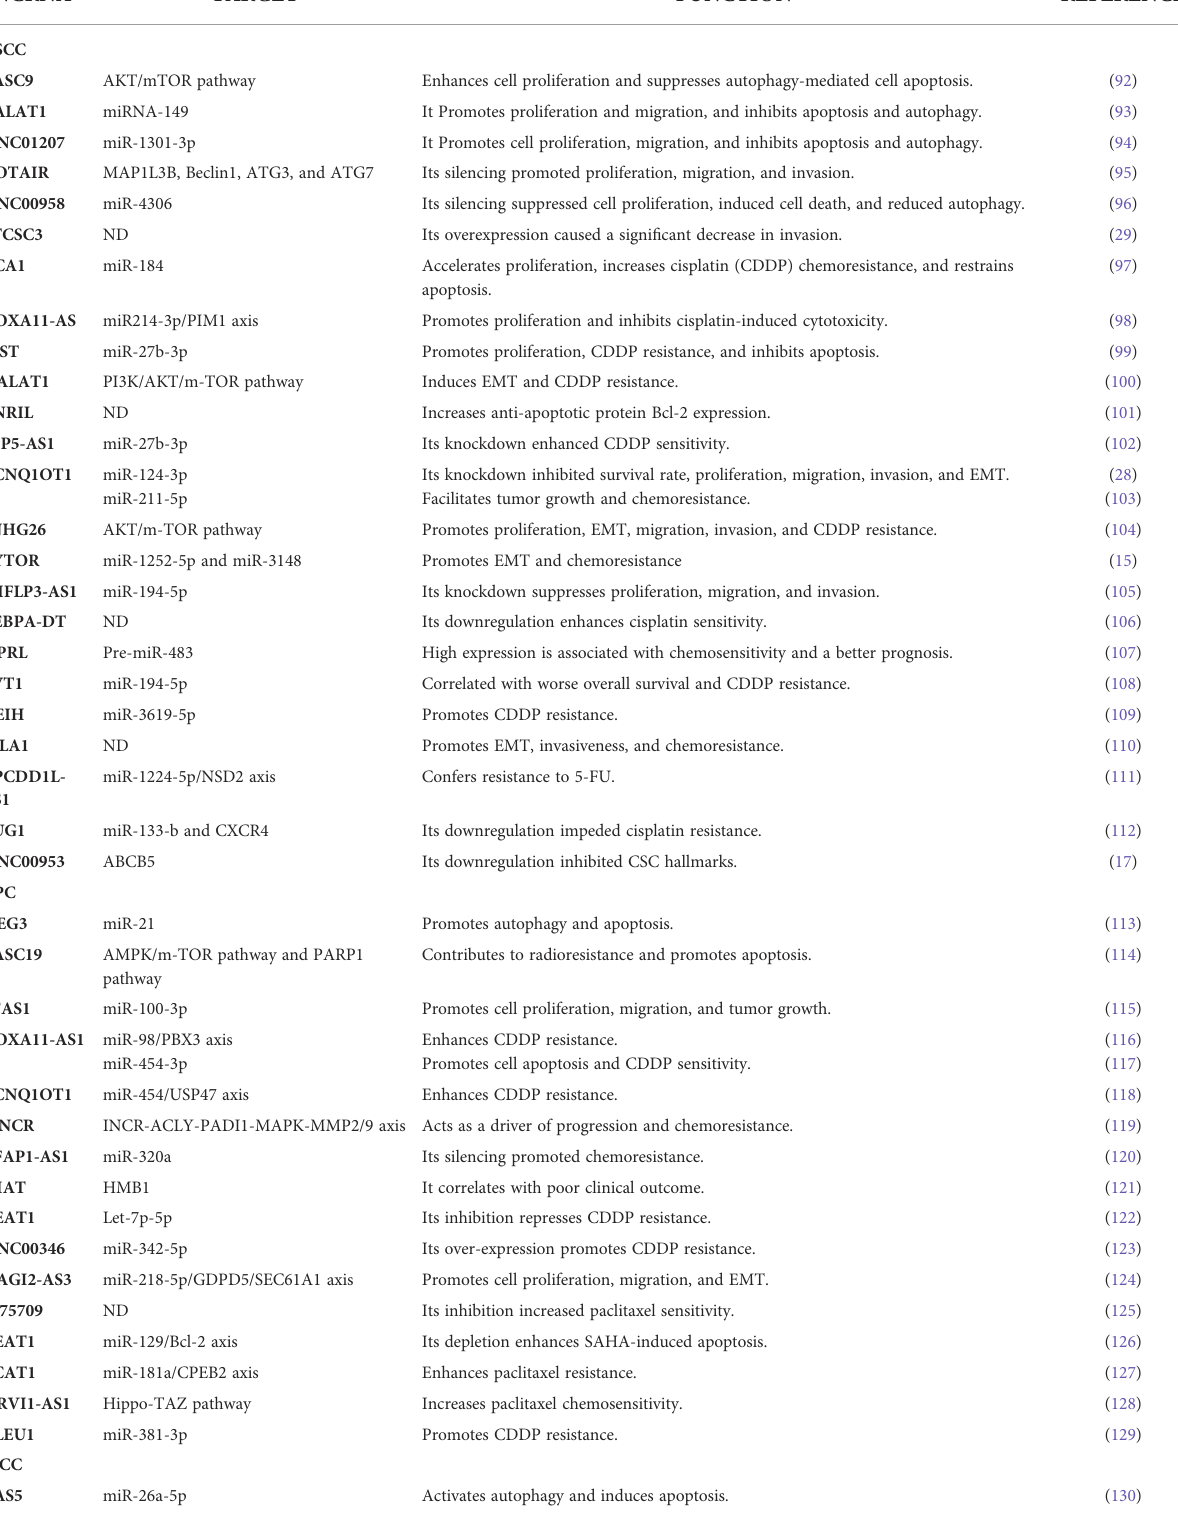
TABLE 1 Overview of proto-oncogene and tumor-suppressor lncRNAs involved in head and neck cancers. LNCRNA TARGET FUNCTION